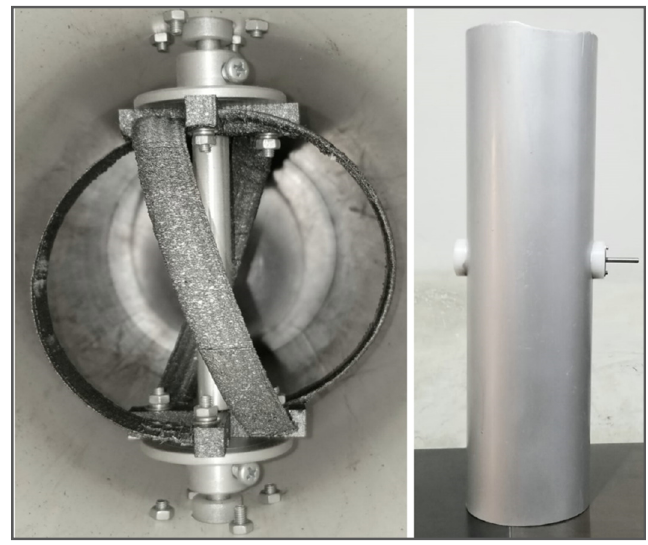
Figure 15. Prototype assembly and testing setup.